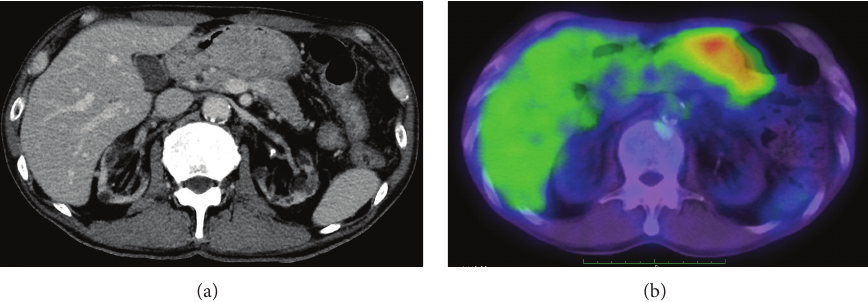
Figure 2: (a) A computed tomography scan revealing a slightly enhanced lobular tumor (34mm × 54 mm) protruding into the duodenum bulb. (b) Positron emission tomography showing an accumulation of 18 F-fluorodeoxyglucose (60mm × 34mm, maximum standardized uptake value = 5.6).